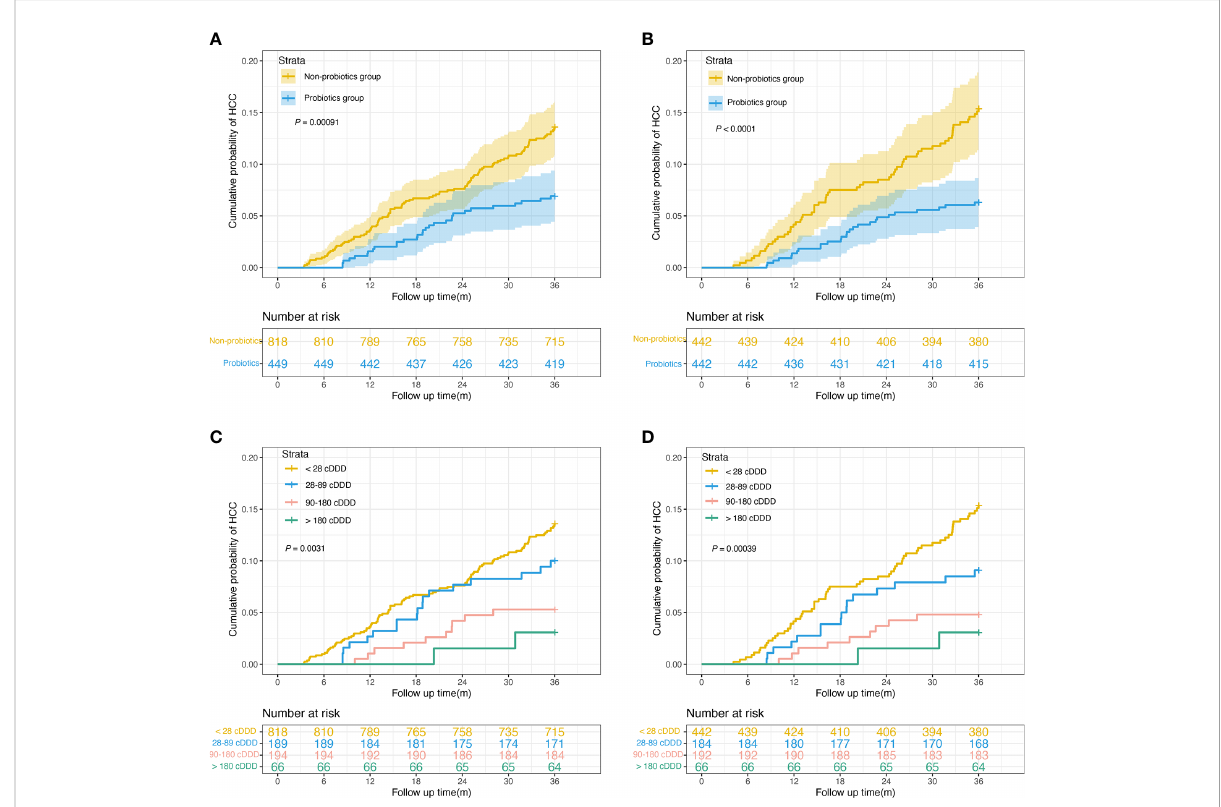
FIGURE 2 Cumulative incidence of HCC in patients with HBC. (A) Cumulative incidence of HCC among probiotics (n = 449) and nonusers (n = 818) in the unmatched cohort (6.7% vs. 12.7%, log-rank test P = 0.00091). (B) Cumulative incidence of HCC among probiotics (n = 442) and nonusers (n = 442) in the matched cohort (6.1% vs. 14.0%, log-rank test P < 0.0001). (C) Cumulative incidence of HCC in patients with < 28 (n = 818), 28 – 89 (n = 189), 90 – 180 (n = 194), and > 180 cDDD (n = 66) of probiotics use before matching (12.7% vs. 9.5% vs. 5.2% vs. 3.0%, log-rank test P = 0.0031). (D) Cumulative incidence of HCC in patients with with < 28 (n = 442), 28 – 89 (n = 184), 90 – 180 (n = 192), and > 180 cDDD (n = 66) of probiotics use after matching (14.0% vs. 8.7% vs. 4.7% vs. 3.0%, log-rank test P = 0.00039). HCC, hepatocellular carcinoma; HBC, hepatitis B- related cirrhosis; cDDD, cumulative de fi ned daily